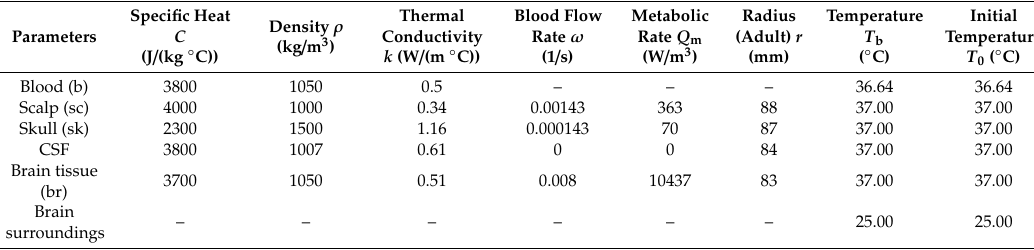
Table 5. Physical parameters used in the simulation